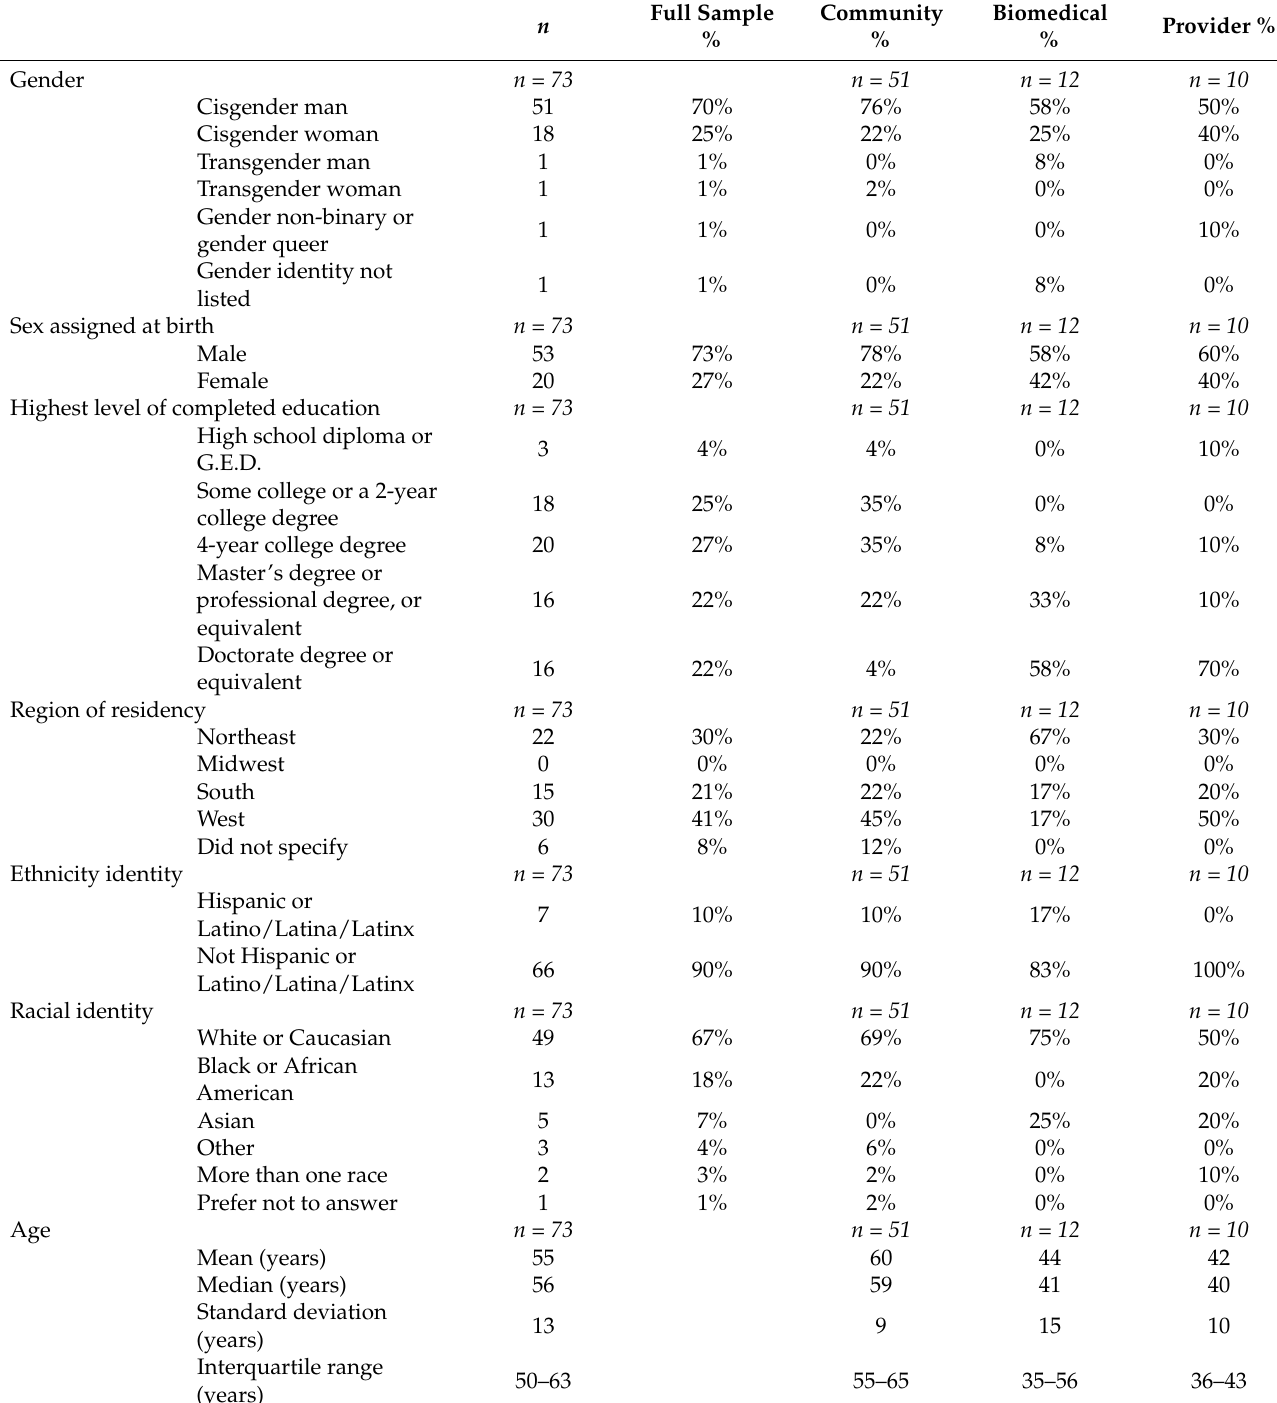
Table 1. Demographic characteristics of survey respondents (United States,